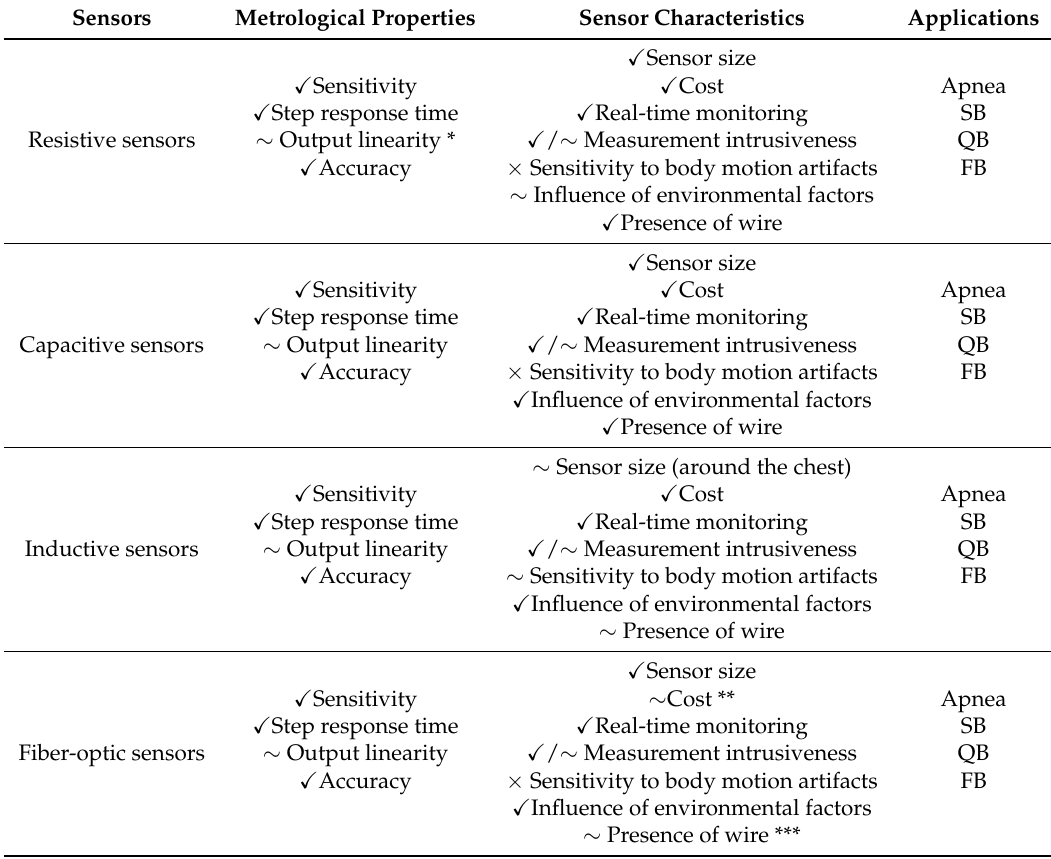
Table 6. Main metrological properties and characteristics of the strain sensors used for f R measurement. (cid:88) good to excellent, ∼ sufficient, ×